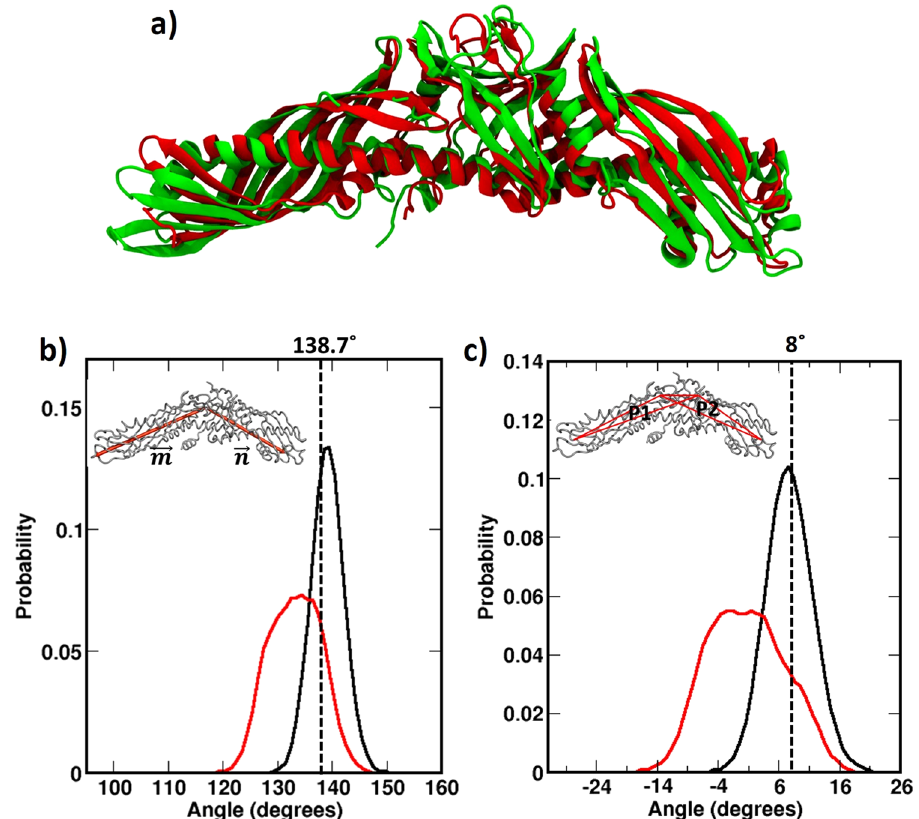
Figure 6. Comparison of TG- and CE-bound CETP structures. ( a ) Superposition of average structures of TG bound (green) and CE bound CETP (red) obtained from respective simulation trajectories. ( b ) Probability distribution of bending motion exhibited by CETP when bound to TG (red) and CE (black) during UA simulations. Bending was estimated from the angle between two vectors, and as shown in the inset. The dotted line indicates the angle of bending observed in CE-CETP crystal structure. ( c ) Probability distribution of twisting/untwisting motion exhibited by CETP when bound to TG (red) and CE (black) during UA simulations. Twisting was computed by measuring the angle between two planes, P1 and P2 as shown in the inset. The twist angle observed in CE-CETP crystal structure is shown in dotted line for